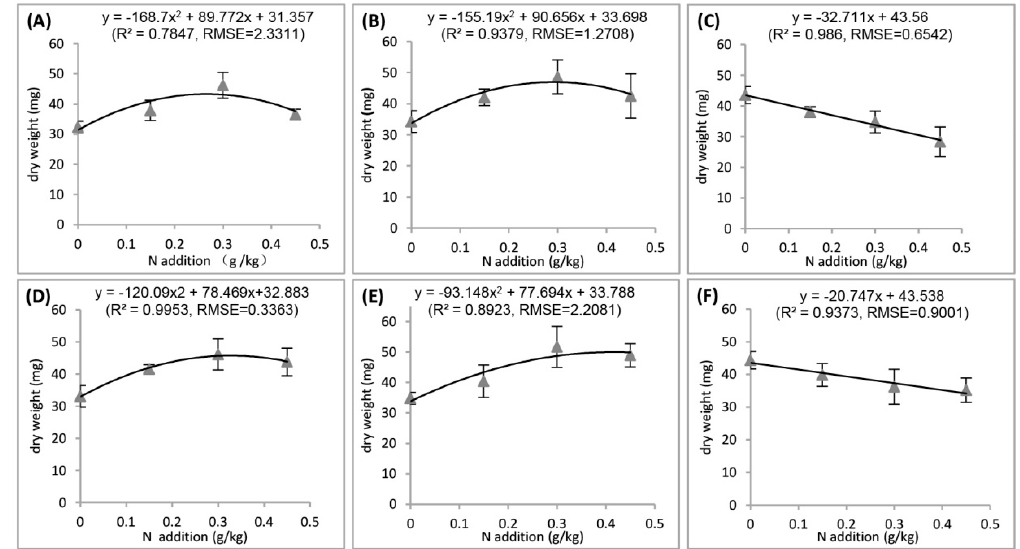
Figure 2. Relationships between pakchoi dry weight and N addition under di ff erent light conditions of T1L1( A ), T1L2( B ), T1L3( C ), T2L1( D ), T2L2( E ), T2L3( F ). Regression equation, R 2 and root mean square error (RMSE) are also presented.